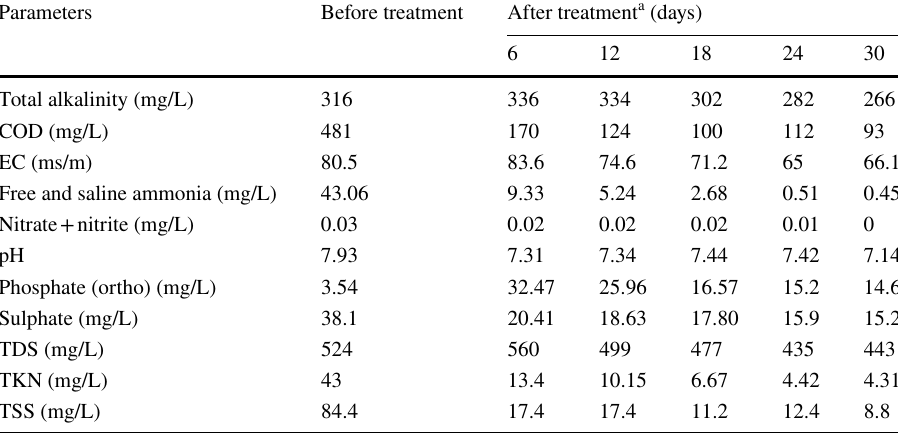
a Average from three-pilot